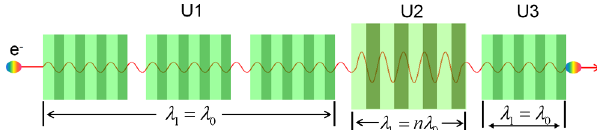
FIG. 1. Ratio of power gain length L ð n Þ 1D =L ð 1 Þ 1D for various un- dulator K values. FIG. 2. Schematic layout of a pSASE